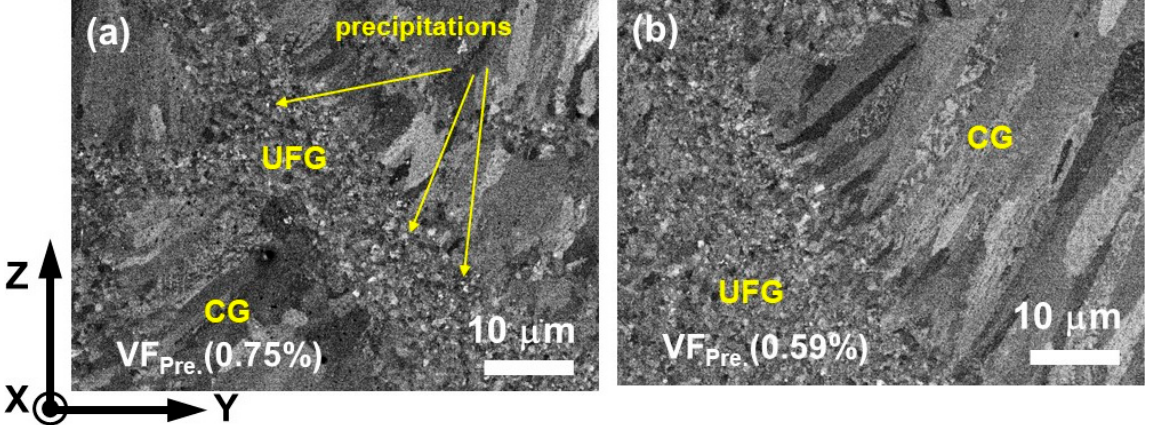
Figure 5. BSE images of ( a ) X- and ( b ) XY-samples in the YZ plane with the VF of precipitates.